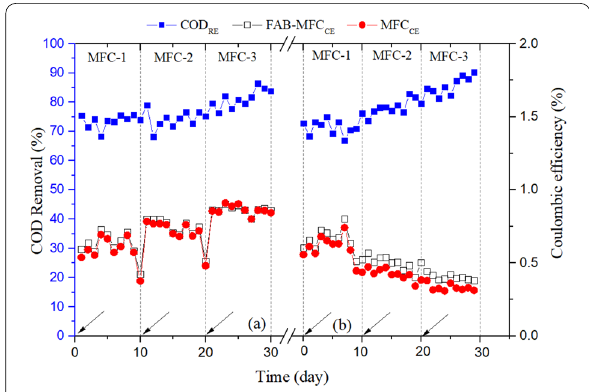
Fig. 6 Effects of a anaerobic-MFC and b aerobic-MFC integrated system on the FAB–MFC performance in terms of COD removal arrows indicate treatment phase change: previous phase contents emptied, and the system allowed to re-stabilize